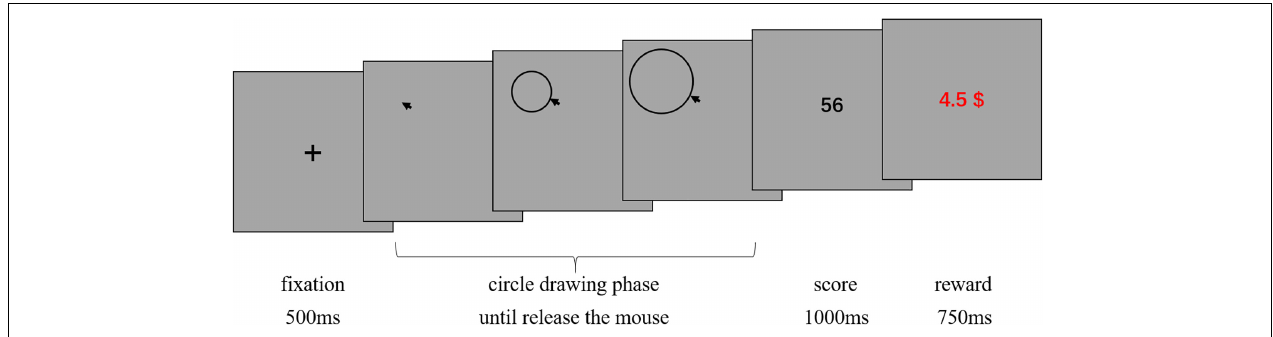
FIGURE 2 | The procedure used in Study 2. For each trial, a fixation cross appeared on the screen for 500 ms; participants were required to draw a circle on the screen by continually pressing the mouse button and dragging the mouse. The center of the circle was located where the mouse button was pressed. The circle enlarged as the mouse was dragged away from the initial location, or shrank when the mouse was dragged toward the initial location. When the mouse button was released, the drawing of the circle was finished. The radius was the distance between the pointer and the center. When the circle drawing phase ended, the score they received was presented for 1 s. Then, the reward amount appeared on the screen for 750 ms. The reward was calculated based on the average of all the scores participants got till that point and served as an immediate reward feedback. Participants could know how much money they would eventually earn based on their current level of